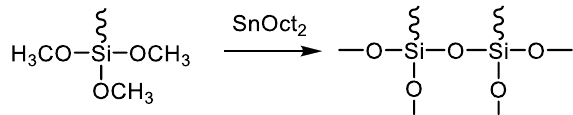
Chart 2. Reaction mechanism of intermolecular elimination catalyzed by SnOct 2 .